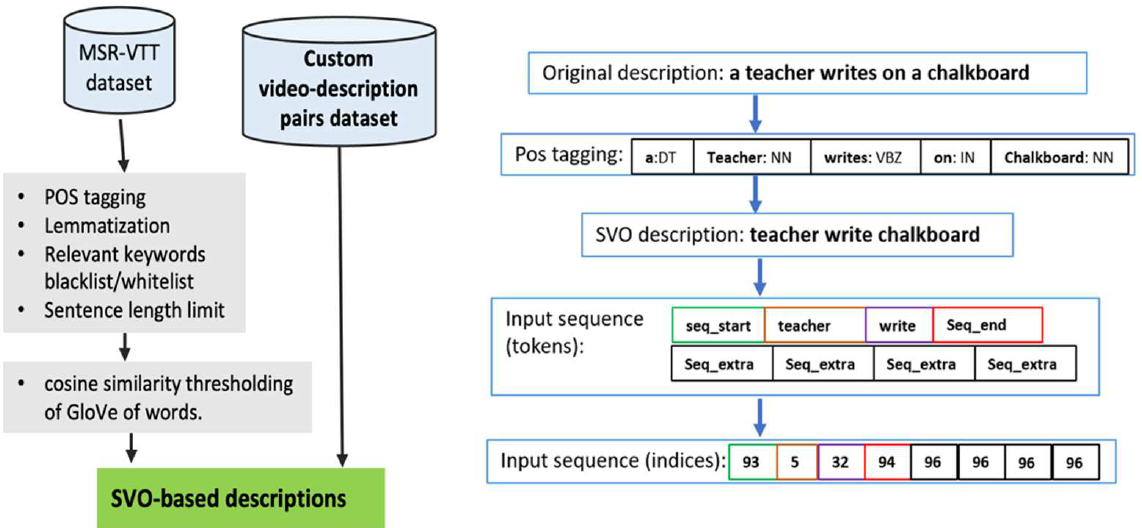
Figure 2. Left : Preprocessing steps to perform on MSR-VTT and custom dataset for retrieving rele- vant data and converting captions to the subject-verb-object (SVO) template. Right : An example showing the result of applying these steps on a video caption.